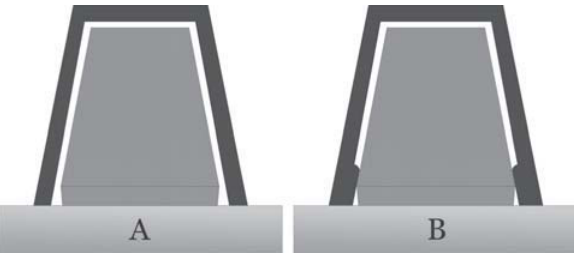
FIGURE 1- Schematic drawing of acrylic impression copings. 1A - acrylic coping without cervical contact; 1B - acrylic coping with cervical